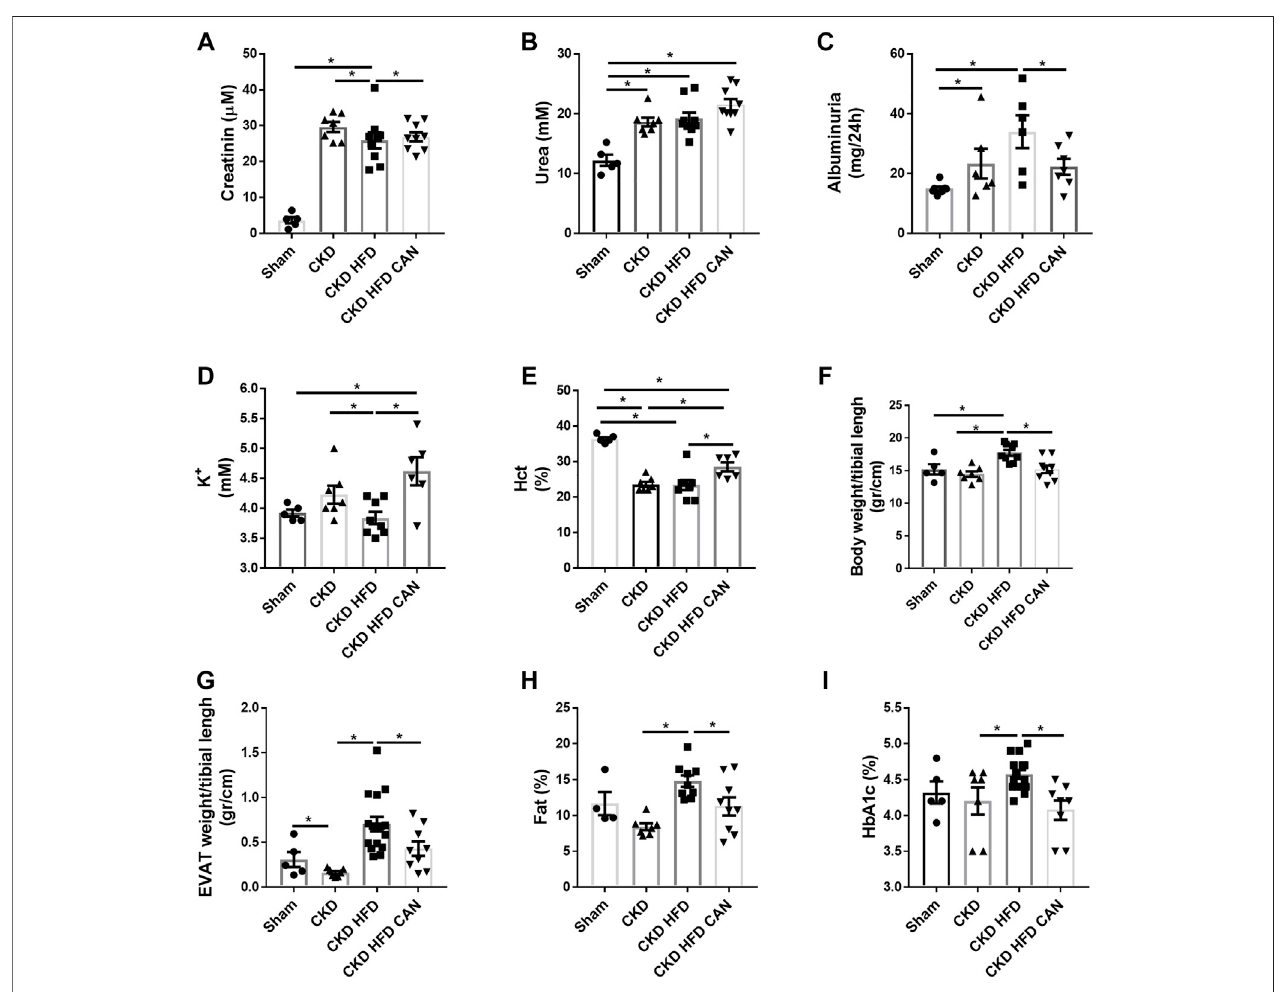
FIGURE 1 | Physiological parameters of the groups Sham, CKD, CKD HFD and CKD HFD CAN. (A) Plasma creatinine; (B) plasma urea; (C) Albuminuria; (D) plasma potassium; (E) hematocrit (Hct); (F) body fat percentage; (G) body weight; (H) epididymal adipose tissue (EVAT) weight and (I) glycated hemoglobin (HbAc1). Statistical analysis by one-way ANOVA with Tukey post-test, * p < 0.05 n = 5 –